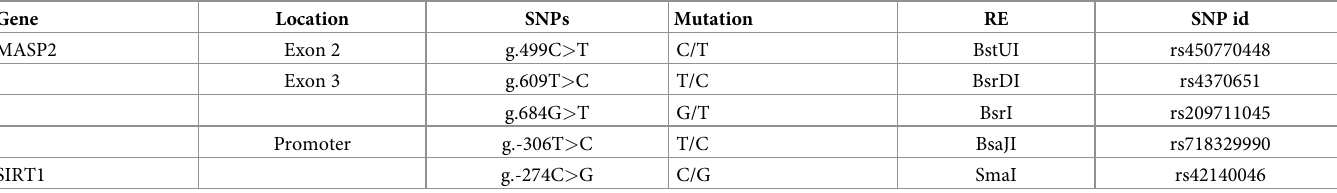
Table 2. Names of genes, region and restriction enzymes used for genotyping for the identified SNPs in MASP2 and SIRT1 genes for Sahiwal cattle breed. Gene